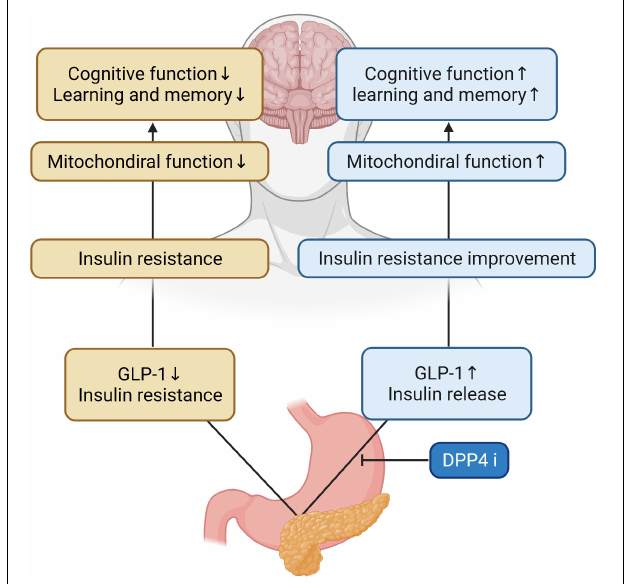
FIGURE 2 | Effects of DPP-4 inhibitor in the AD brain. During DPP-4 inhibitor treatment, GLP-1 increases and insulin is secreted, which improves insulin resistance and mitochondrial function in the brain. Therefore, cognitive function and learning and memory ability are